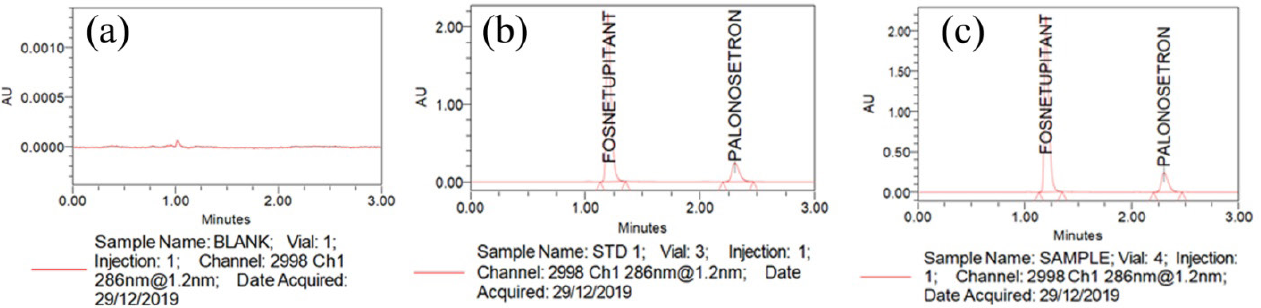
FIGURE 2 - Chromatograms of blank, standard and